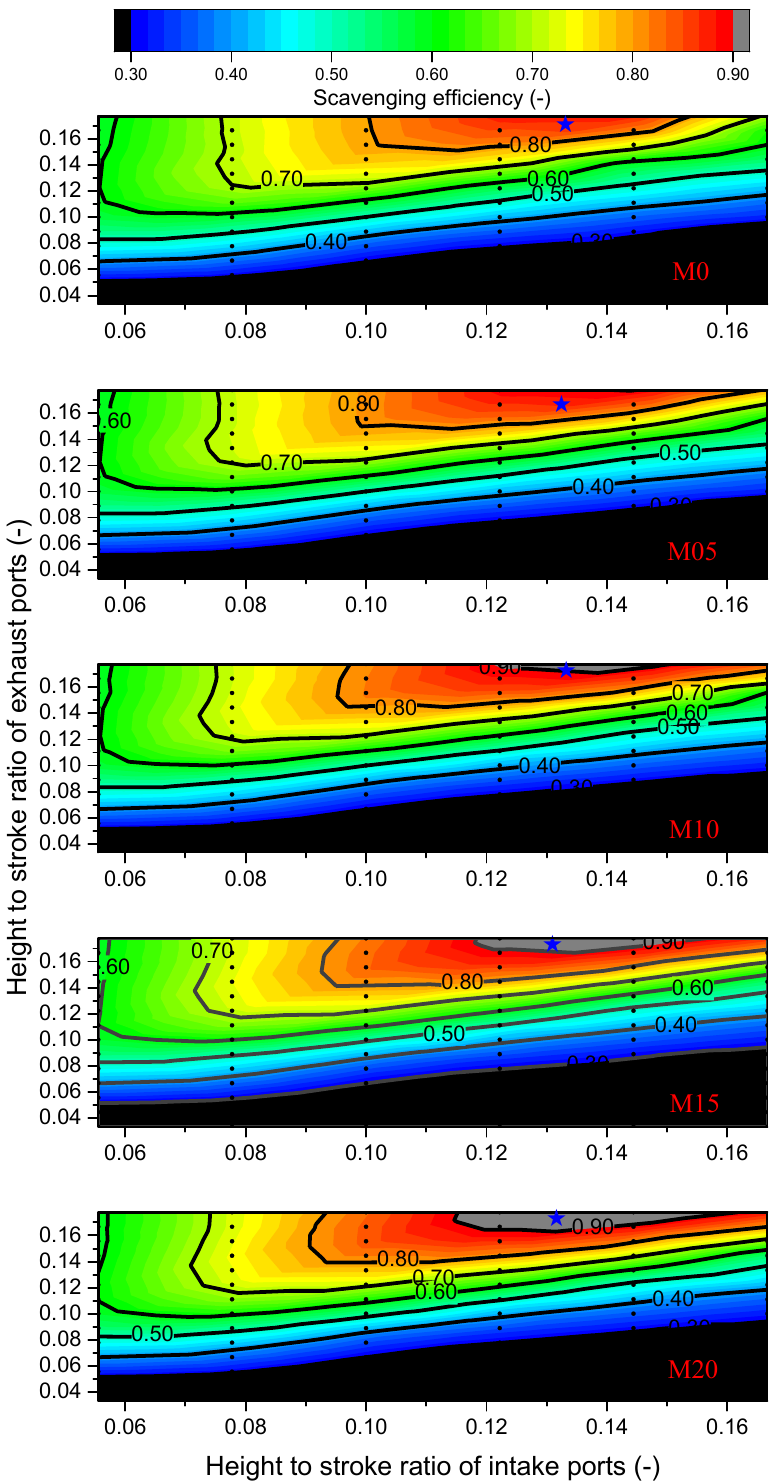
Figure 9. Scavenging efficiency for the interaction of the intake and exhaust ports.